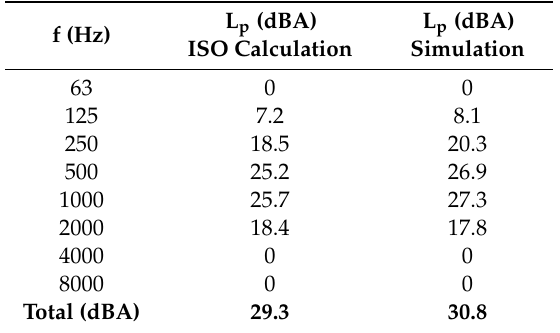
Table 8. Comparison between numerical and analytical results for Receiver 1 at the Llumeres location.